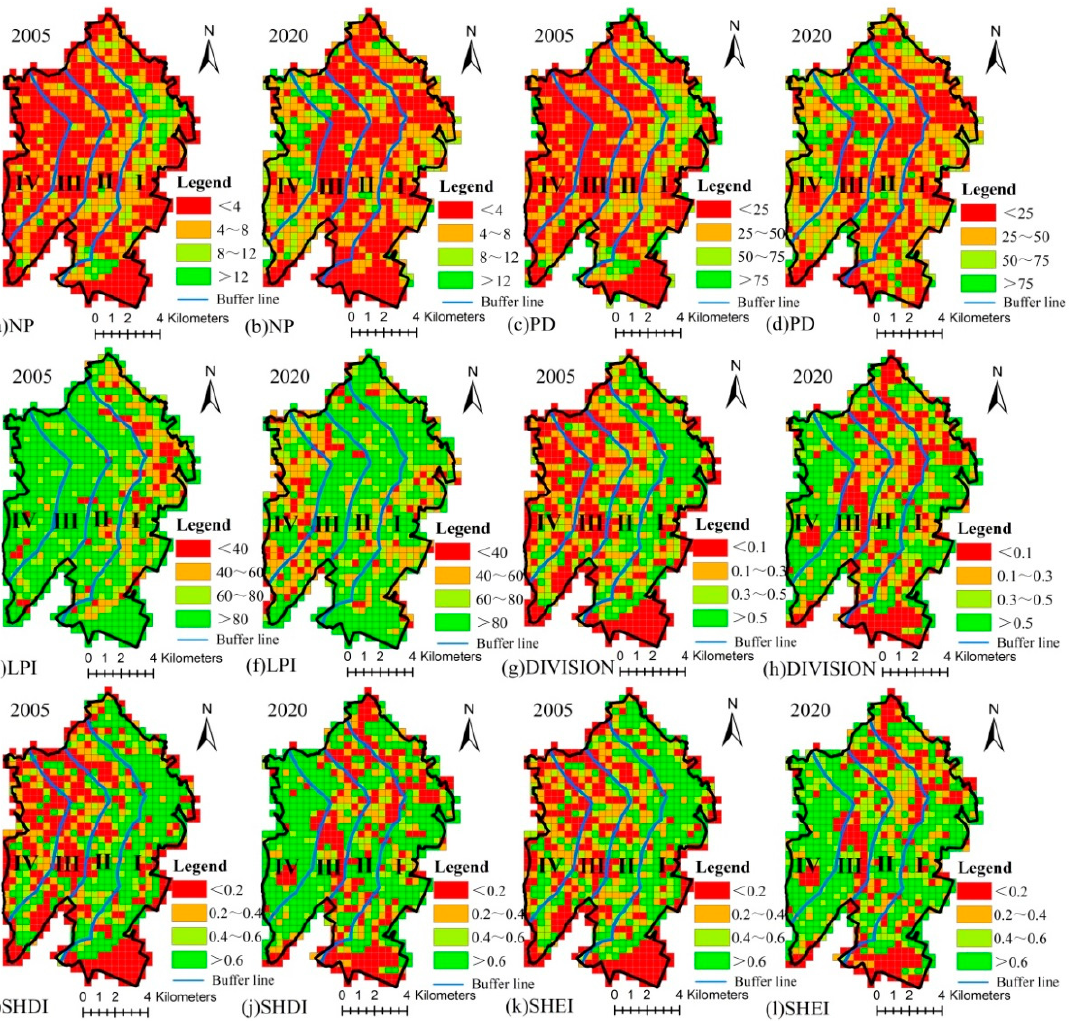
Figure 5. Spatial pattern of landscape metrics in 2005 and 2020. (Gradient I (0–2 km), gradient II (2–4 km), gradient III (4–6 km) and gradient IV (>6 km) from the coastline to the inland).